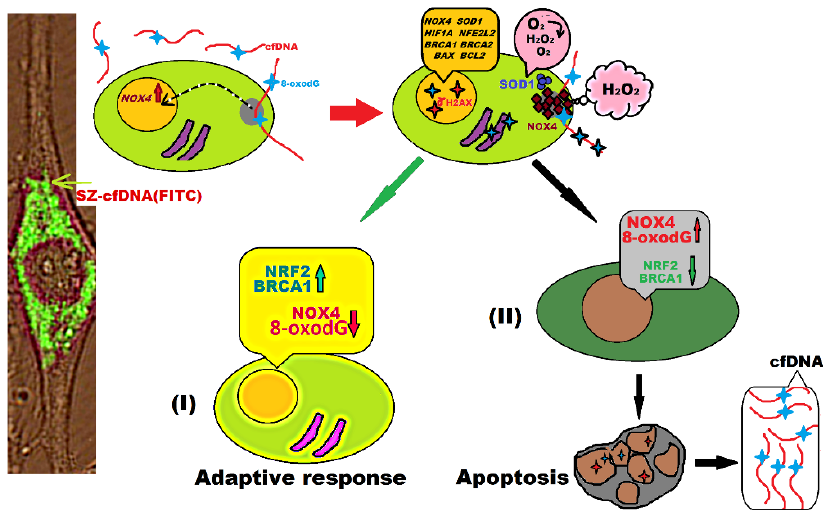
Figure 9. Scheme describing the cell response to the action of cfDNA fragments. A photo from the previous article of a cell interacting with the sz-cfDNA is provided [29].